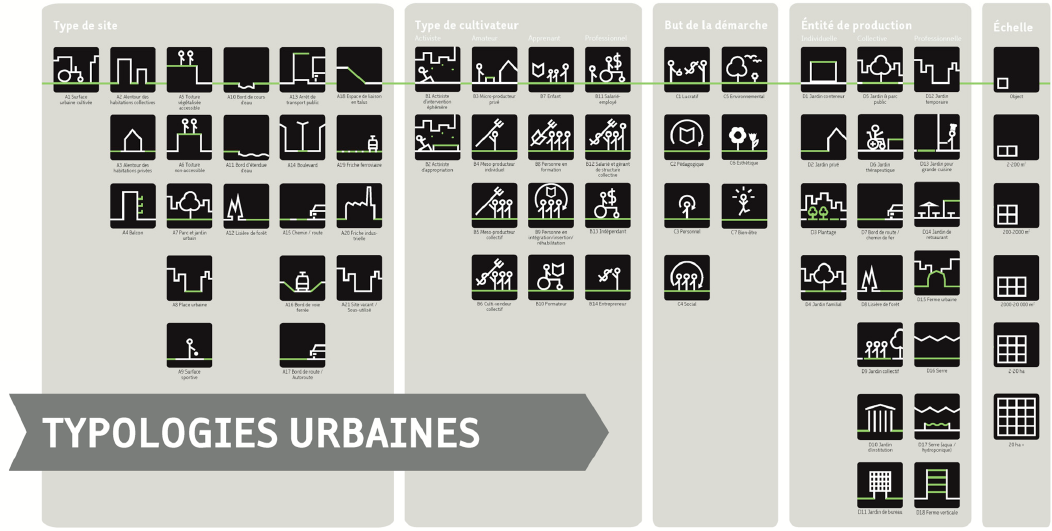
Figure 4. “Synoptic table of typologies” proposed in Verzone and Woods’ Food Urbanism concept. Image courtesy of Food Urbanism Initiative-Verzone Woods Architectes.